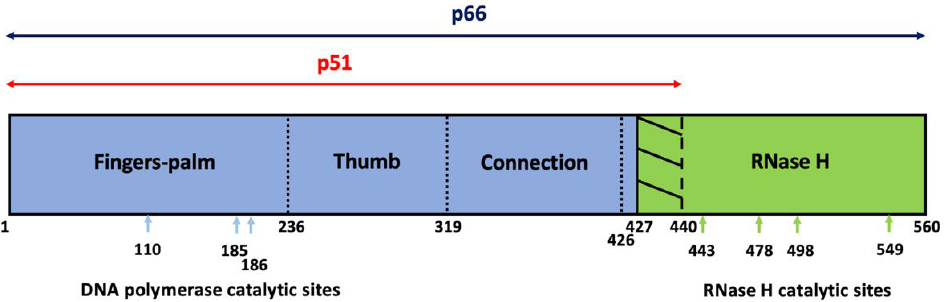
Figure 1. Schematic representation of HIV-1 RT structure. HIV-1 RT consists of two subunits, p66 and p51. The p66 subunit harbors both DNA polymerase (blue segment) and RNase H (green segment) domains, whereas p51, which is a proteolytic cleavage product of p66 subunit, does not have an active RNase H domain (residue 427–440). HIV-1 RT DNA polymerase domain, which captures DNA primer annealed to RNA or DNA template, in the form of a clasping right hand, can be further classified into the finger, palm, and thumb subdomains, whereas the connection subdomain links polymerase and RNase H domains. Amino-acid residues crucial for the enzymatic catalytic sites of DNA polymerase and RNase H activities are marked with respective colors.